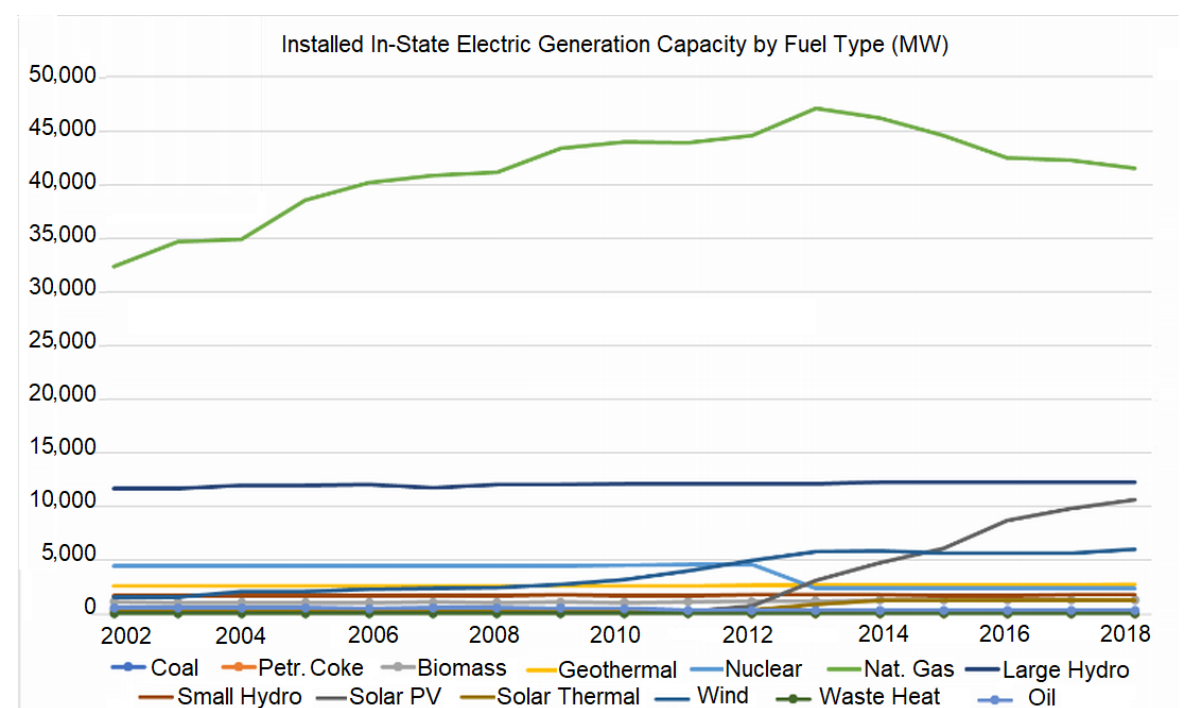
Figure 4. California’s capacity by fuel type.